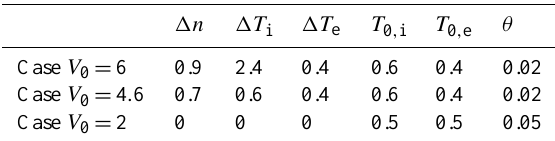
Table 1. The values of the quantities for the different simulation